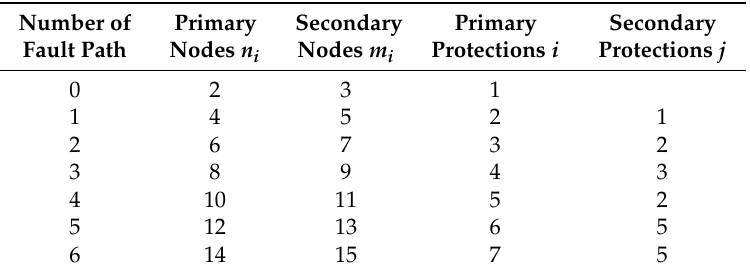
Table 4. Radial power system fault paths.